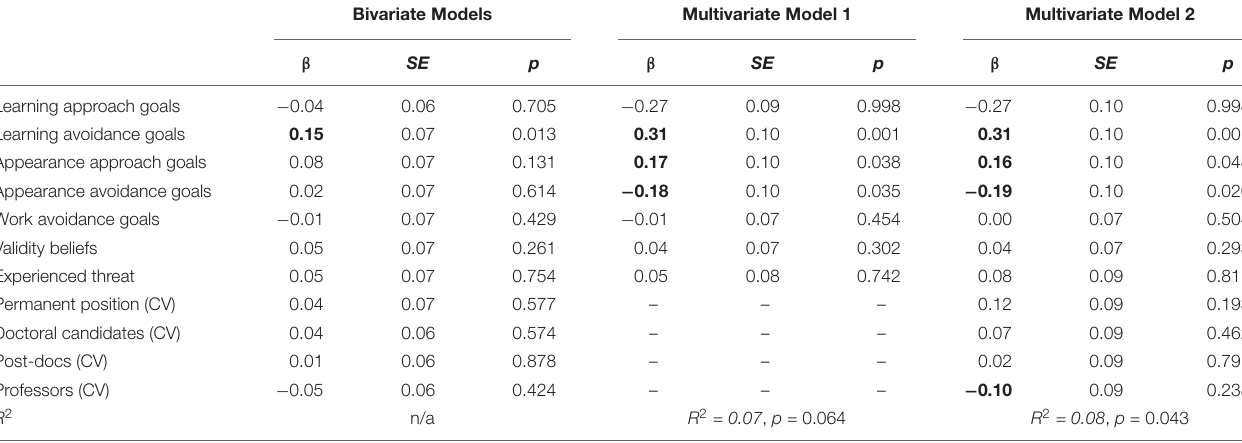
TABLE 2 | Results of the latent SEMs for associations with later voluntary conducted SET(s).